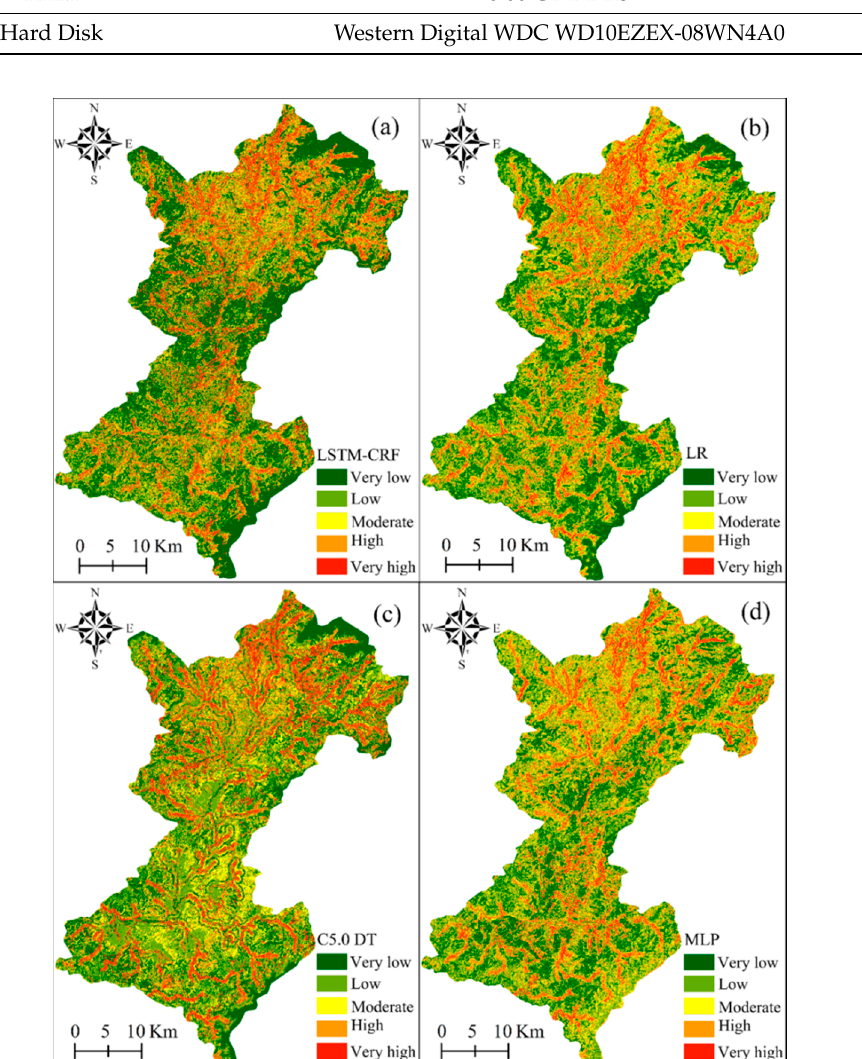
Figure 6. Landslide susceptibility map (LSM) produced by the four models. LR: Logistic regression, C5.0 DT: C5.0 decision tree, MLP: Multilayer perceptron.